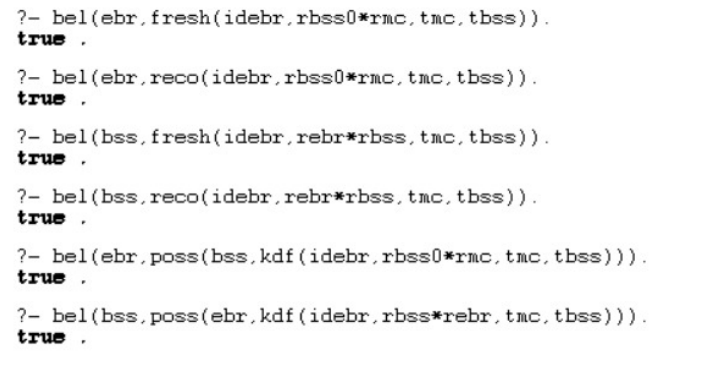
Figure 2. Prolog verification results of the